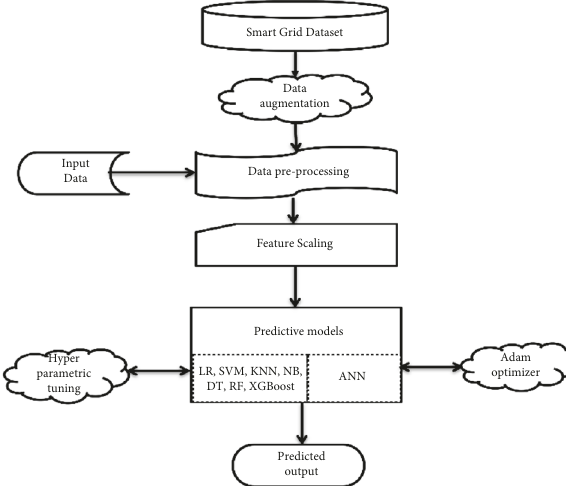
Figure 4: Flow chart of the